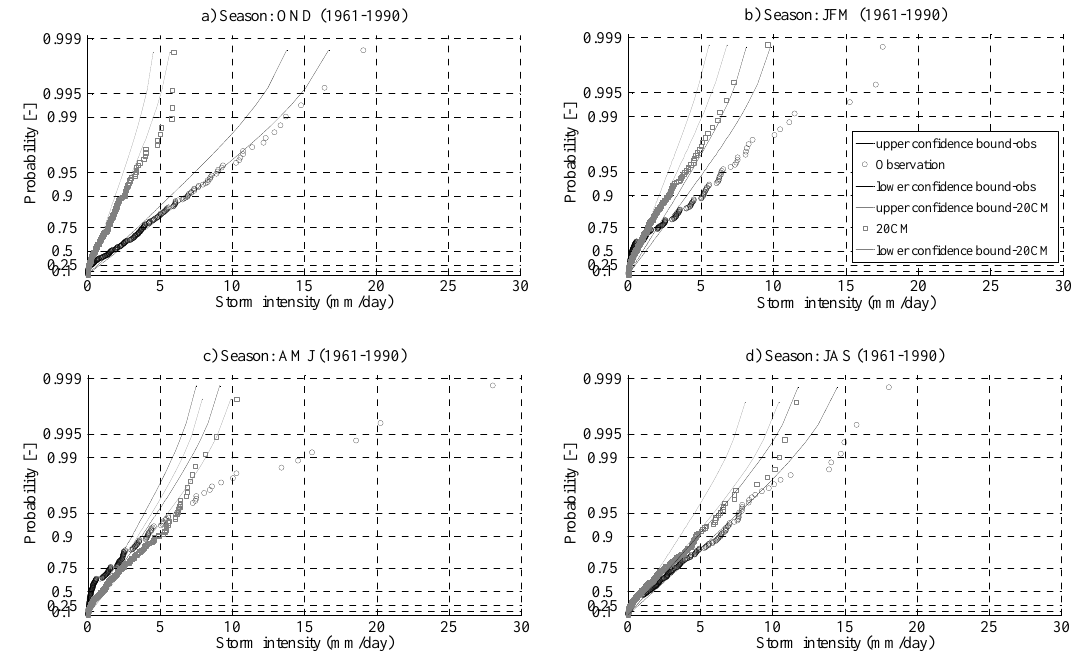
Fig. 2. Comparison between the RCM simulation for the reference period (squares) and the rainfall observations (circles), using the ex- ponential probability plots of the storm intensity with 95% confidence bands of their corresponding theoretical distributions for autumn (OND) (a) , winter (JFM) (b) , spring (AMJ) (c) and summer (JAS) (d) . The reported data refers to one single RCM grid-cell (cell #4) and the corresponding rain-gauge